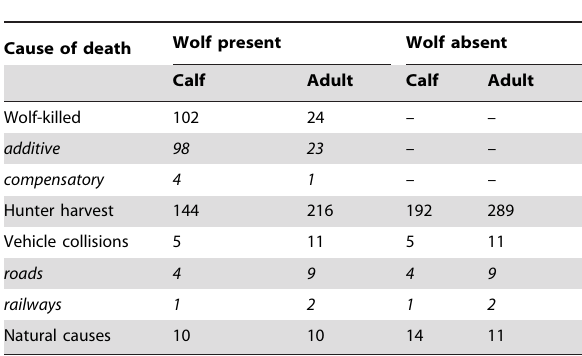
Table 2. Number of moose killed annually from different causes within an area the size of an average annual wolf territory (900 km 2 ) with and without presence of wolves in